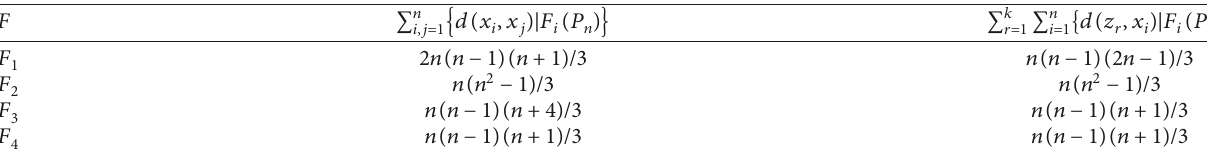
Table 1: WI and DDI of F